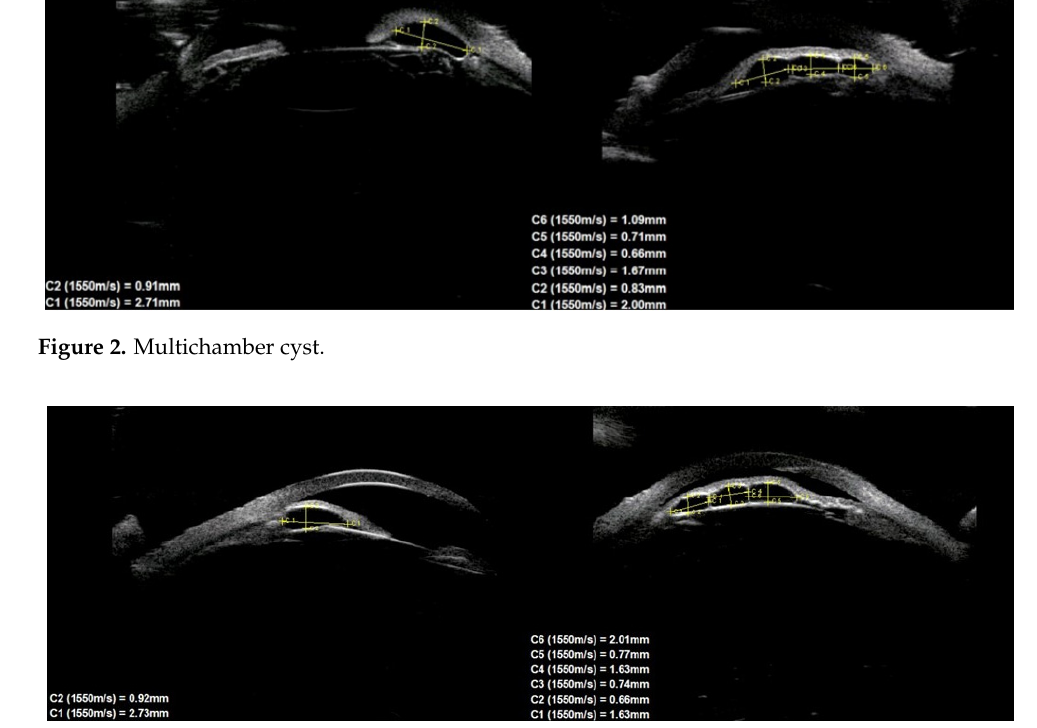
Figure 3. Multichamber cyst.